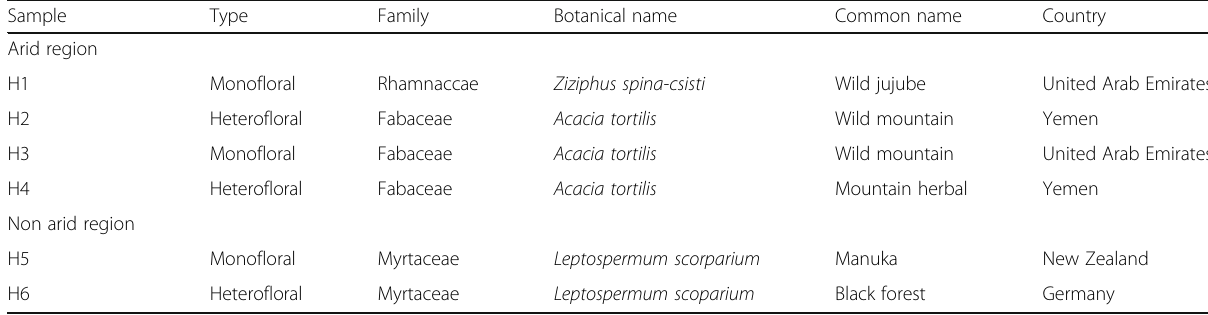
Table 1 Description of honey varieties by region